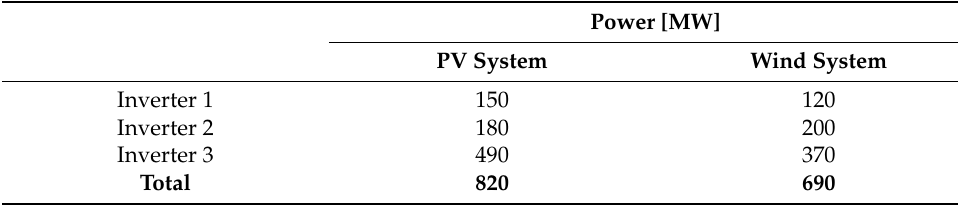
Figure 21. Voltage control loop Bode diagram. Figure 22. Frequency control loop Bode diagram.